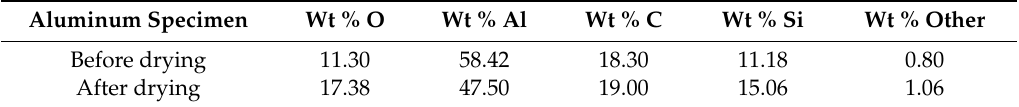
Table 6. EDS analysis of aluminum specimen after the drying process.